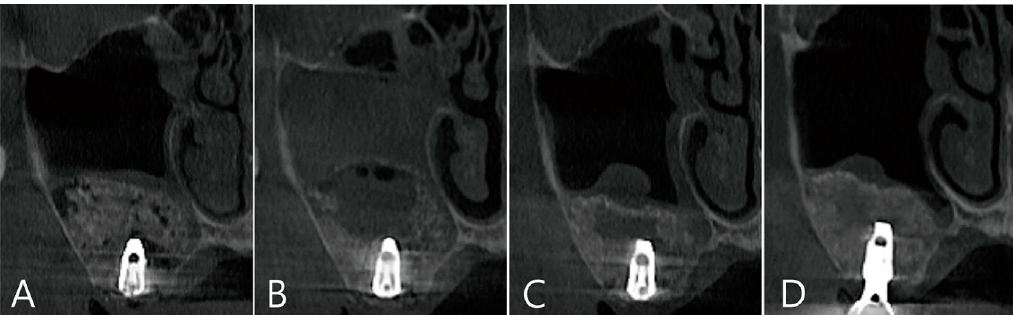
Figure 3. ( A ) Coronal image of the CBCT taken immediately after surgery. There was no perforation of the maxillary sinus membrane and no leakage of the bone graft substitute; ( B ) coronal image of the CBCT taken one week after surgery. A severely enlarged grafting void was observed above the implant apex, and the ostium was obstructed due to severe membrane thickening; ( C ) coronal image of the CBCT taken 6 months after surgery. Although the grafting void was reduced in size, it appears similar to the SCC; ( D ) the radiopacity of the removed grafting void site was increased in the CBCT images taken 6 months after the prosthesis was delivered.